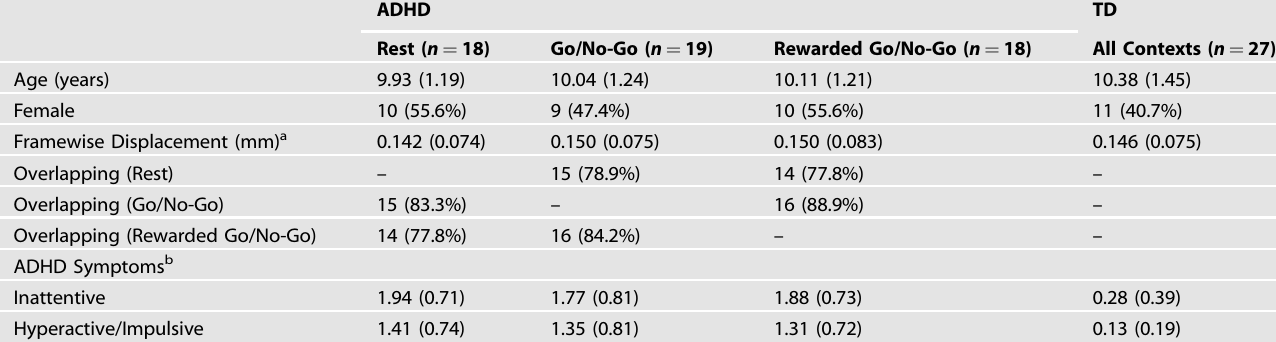
Table 2. MPH Acute Response Sample Characteristics by Scan